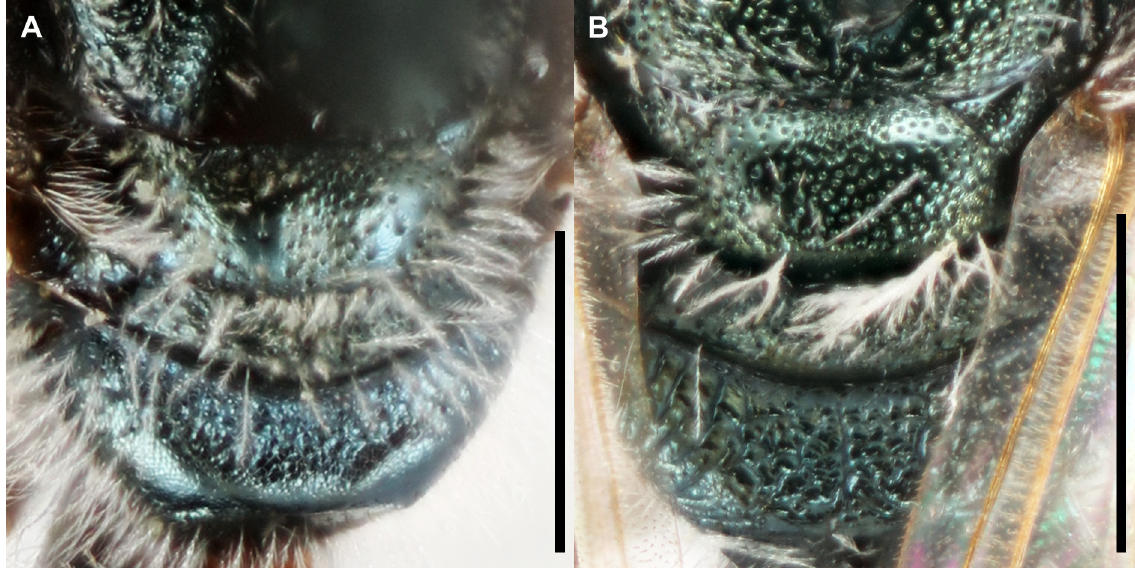
Fig. 94. Scutellum and metapostnotum. A . Lasioglossum gaudiale (Sandhouse, 1924), ♀, scutellum coarsely punctate and metapostnotum rugae not reaching posterior margin. B . L. eremum sp. nov., ♀, scutellum finely punctate and metapostnotum rugae reaching posterior margin. Scale bars = 0.5